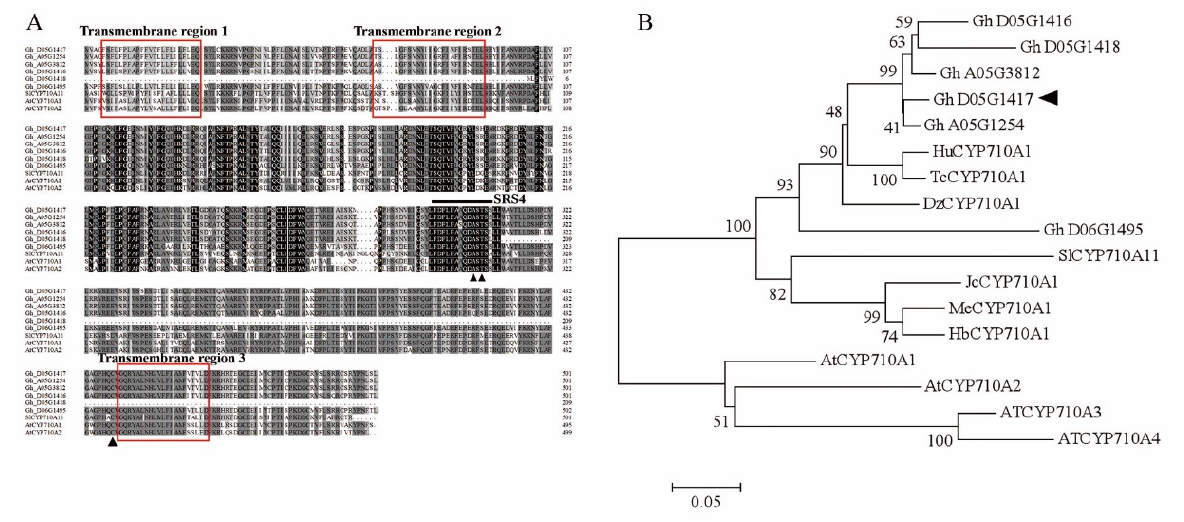
Figure 2. Multi-sequence alignment of GhCYP710A1 with other species CYP710A proteins and phy- logenetic tree analysis of CYP710A homologues. ( A ) Multi-sequence alignment of GhCYP710As and SlCYP7010A11 ( Solanum lycopersicum ) and AtCYP710As ( Arabidopsis thaliana ). Black shading repre- sents conserved amino acid residues; gray shading represents similar amino acid residues; the black line indicates conserved amino acids of the substrate recognition site SRS4 in the I-helix region; ▲ indicates the conserved alanine residues (A), threonine residues (T) and heme ligand cysteine resi- due (C). Red box indicates the transmembrane region. ( B ) Phylogenetic analysis was performed using the MEGA5.2 software with the neighbor-joining (NJ) method under 1000 replicates of